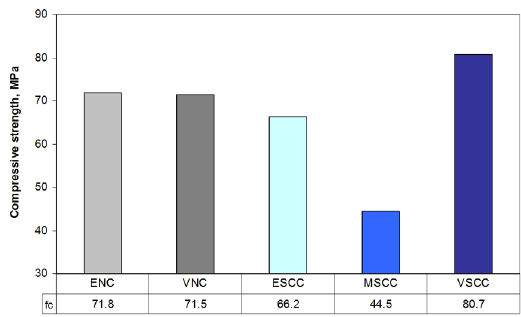
Figure 8. Average compressive strength of normal concrete